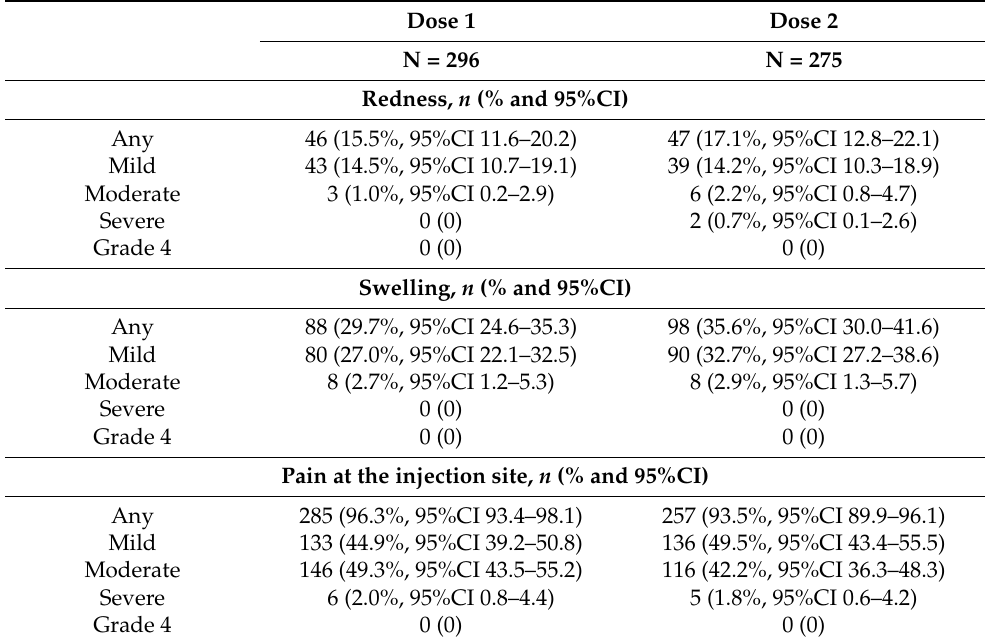
Table 2. Reporting of local adverse reactions in the 7 days after the first and second vaccine dose administration, stratified by symptom